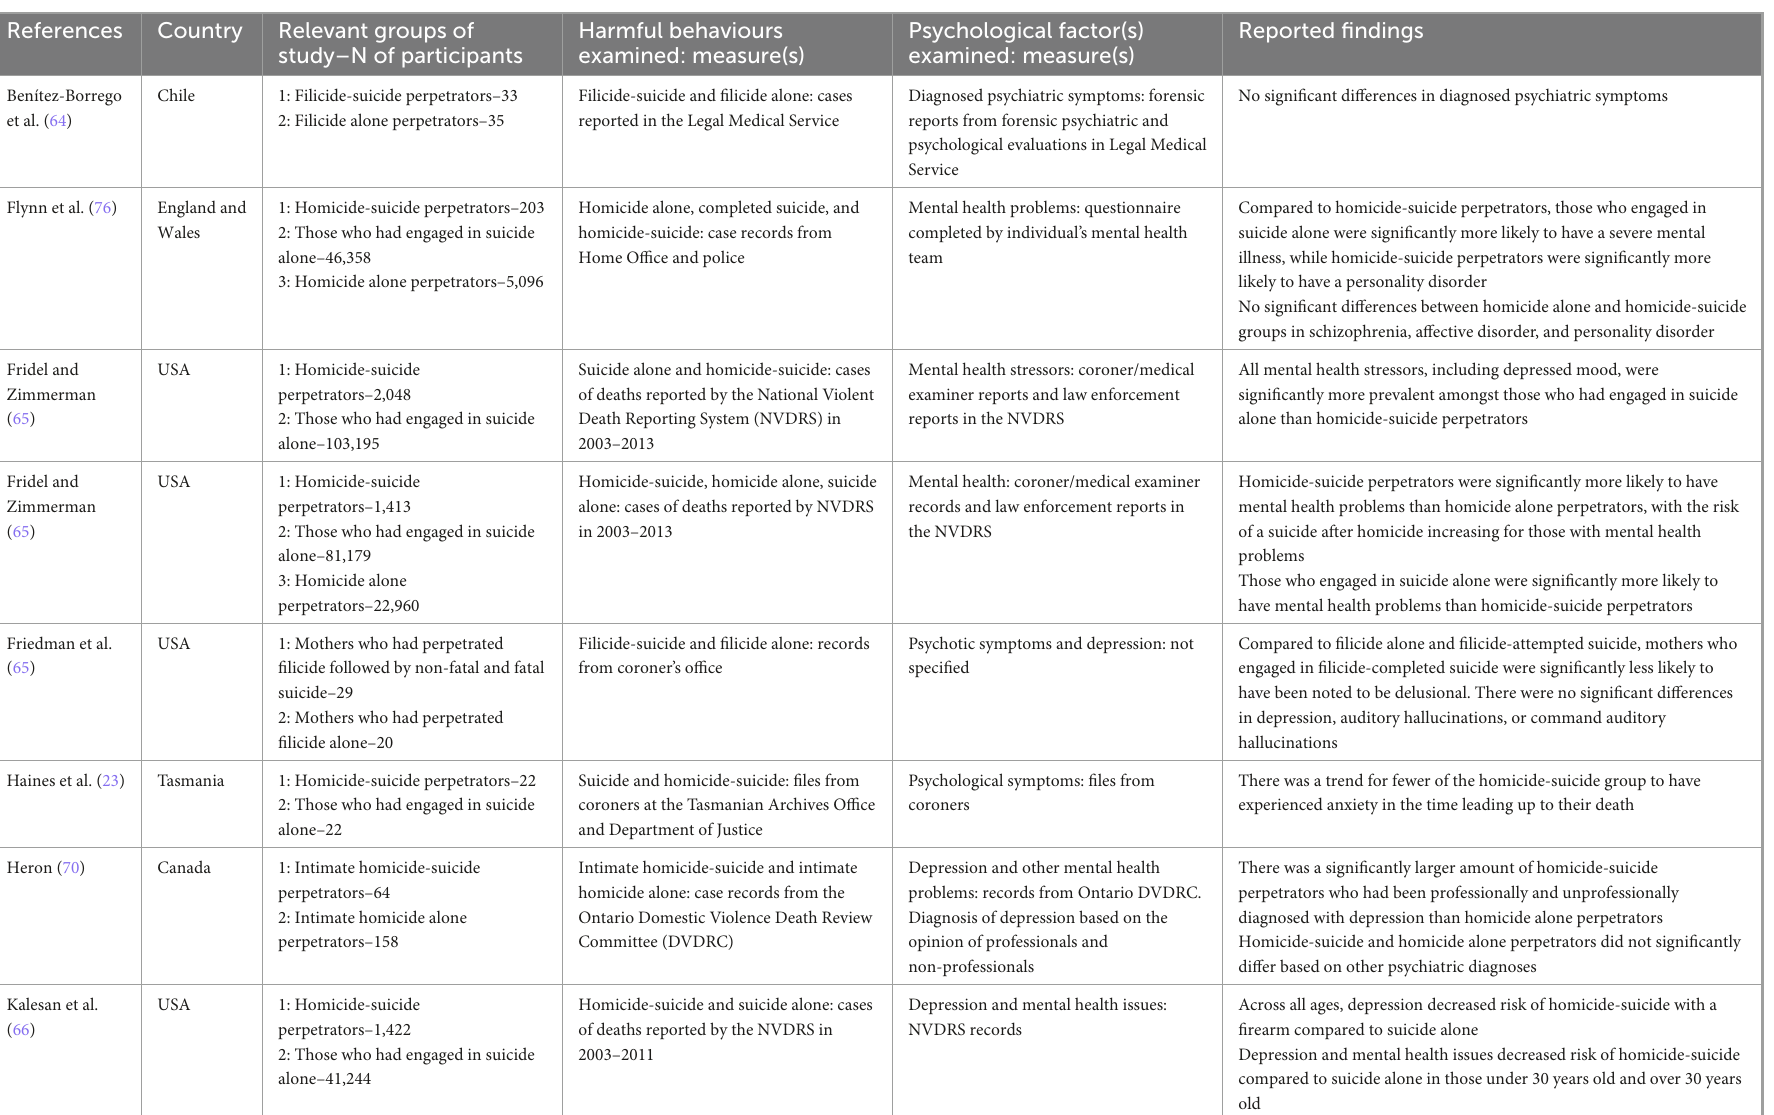
TABLE 2 Summary characteristics of homicide-suicide